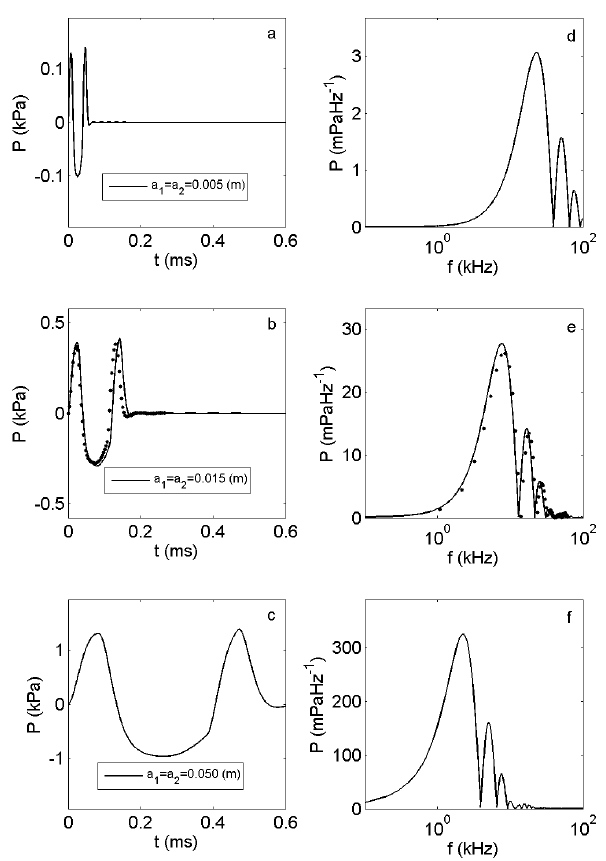
Figure 3. Calculations for glass spheres of the same size impacting as the sphere size was increased. (a) – (c) Time domain waveform calculated using Eq. (1) and (d) – (f) frequency spectrum calculated using Eq. (2). Measurements ( • ) are from Thorne and Foden (1988).